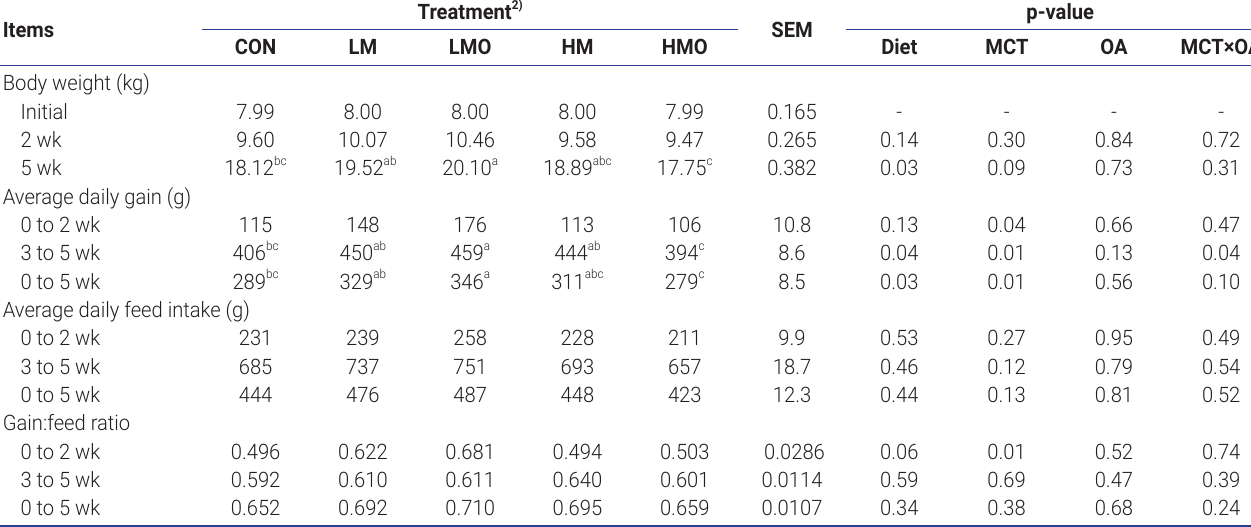
Table 3. Effects of medium chain triglycerides and organic acids on growth performance in weaning pigs